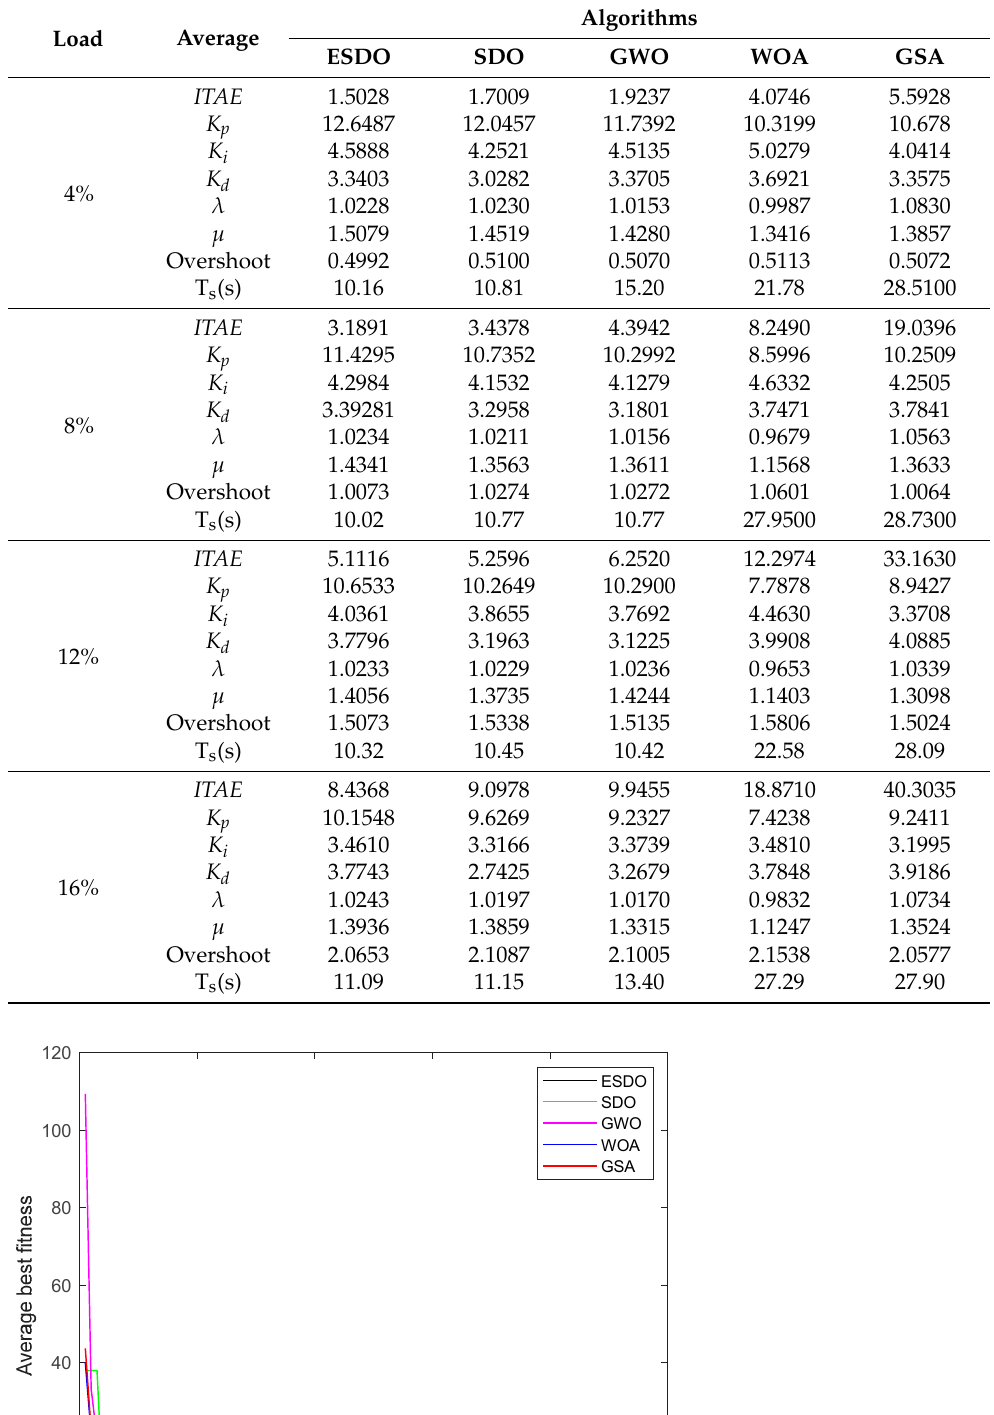
Table 9. Experimental results at 4%, 8%, 12%, and 16% loads.